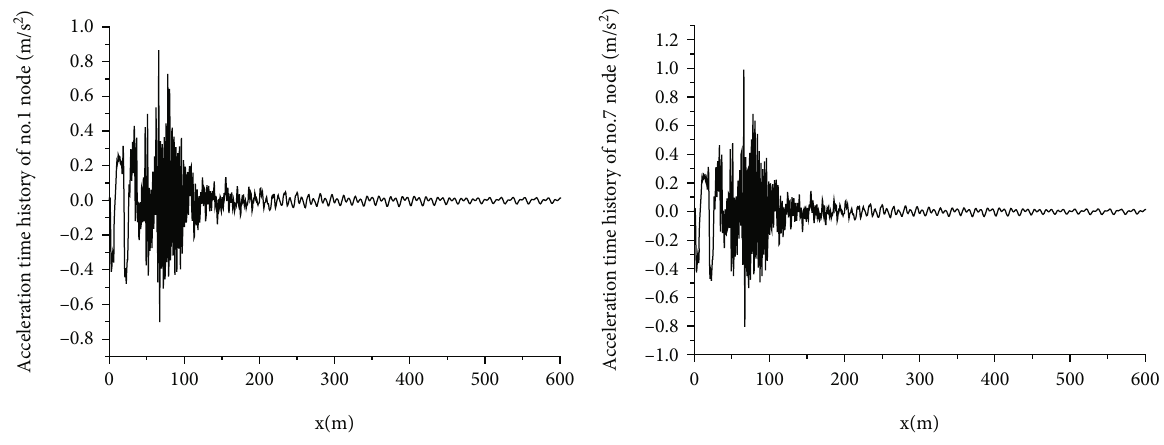
Figure 7: Acceleration time history curve of 7 nodes at 5 T. Table 3: Comfort level of train under di ff erent lines.